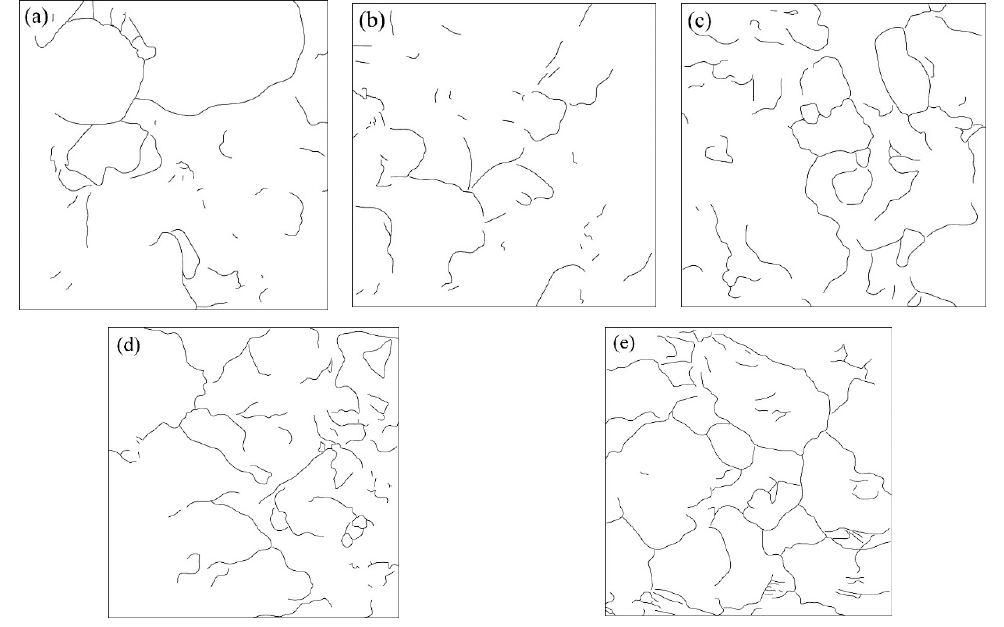
Figure 8. Morphological sketches of crack aggravation with temperature. ( a ) 25 °C; ( b ) 200 °C; ( c ) 400 °C; ( d ) 600 °C; ( e ) 800 °C. ( c ) 400 ◦ C; ( d ) 600 ◦ C; ( e ) 800 ◦